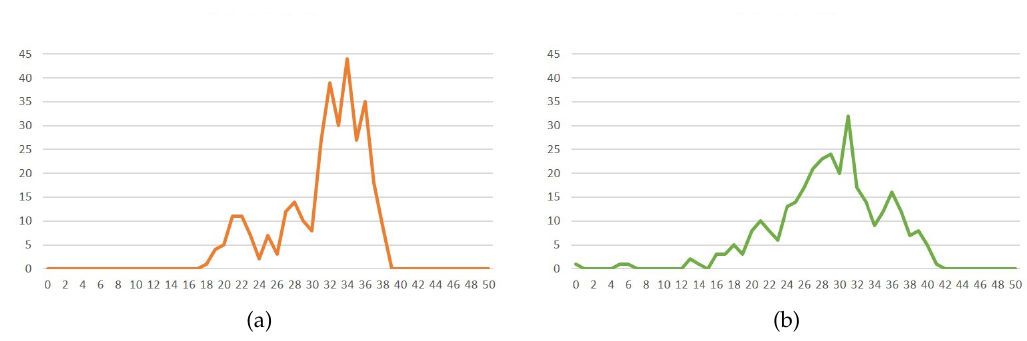
Figure 23. ( a ) The distribution when the focus composition rule is considered. ( b ) The distribution for a random photo taking